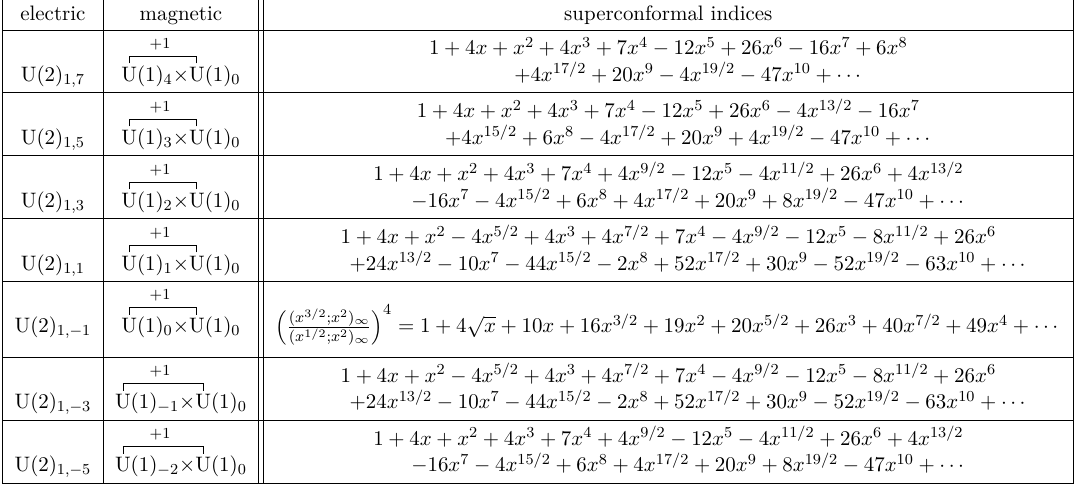
Table 7 . The superconformal indices for ( N, F, k ) = (2 , 2 , 1) with various n